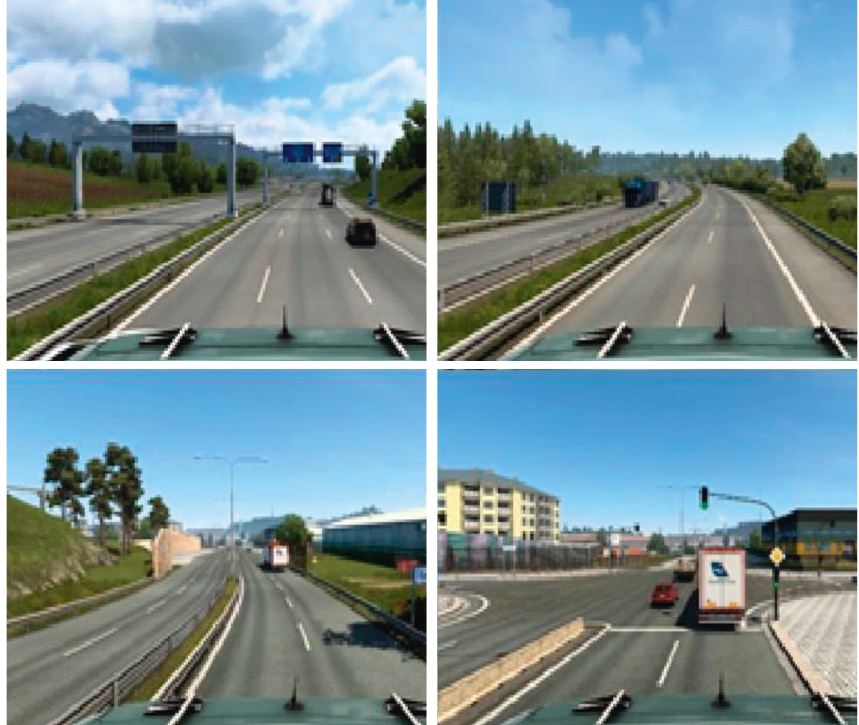
Figure 7: Simulated road